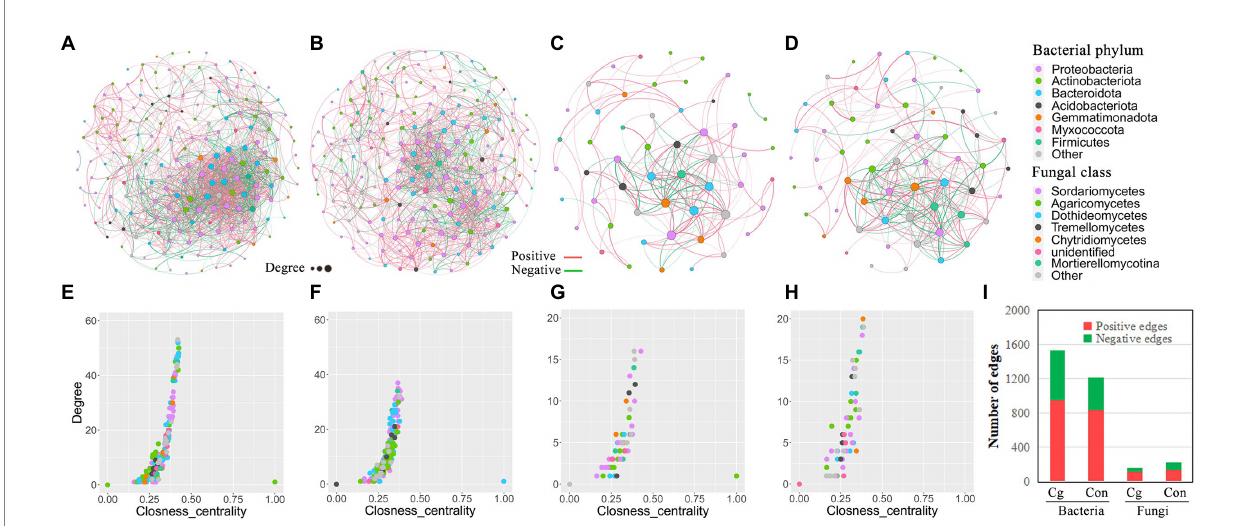
FIGURE 6 Co-occurrence network analysis of bacterial and fungal communities. (A, B) Co-occurrence network of the bacterial communities of the ‘Cg’ (A) and ‘Con’ (B) treatments; (C, D) Co-occurrence network of the fungal communities of the ‘Cg’ (C) and ‘Con’ (D) treatments. The characteristics of co- occurrence networks were shown in Supplementary Table 3, and the taxonomic composition of bacterial phylum and fungal class in the networks were shown in Supplementary Table 4; (E–H) Comparison of node-level topological features (degree and closeness centrality) in ‘Cg’ bacterial (E) , ‘Con’ bacterial (F) , ‘Cg’ fungal (G) and ‘Con’ fungal (H) networks; (I) Number of edges in the ‘Cg’ and ‘Con’